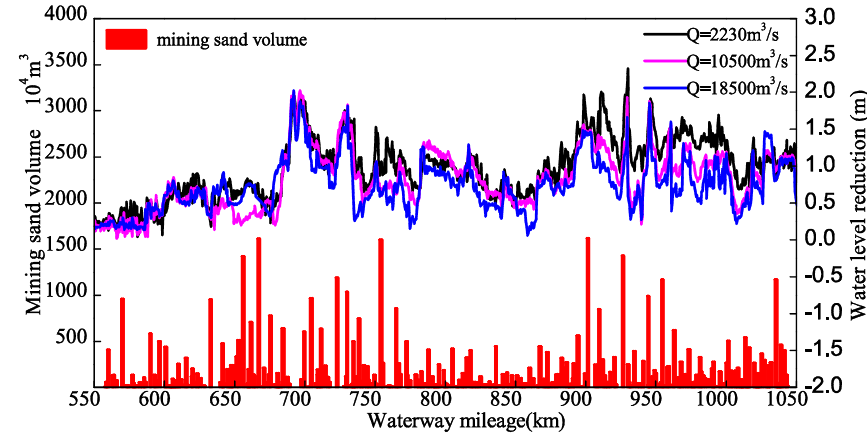
Fig. 22 Correlation of water surface line change and the extracted sand volume